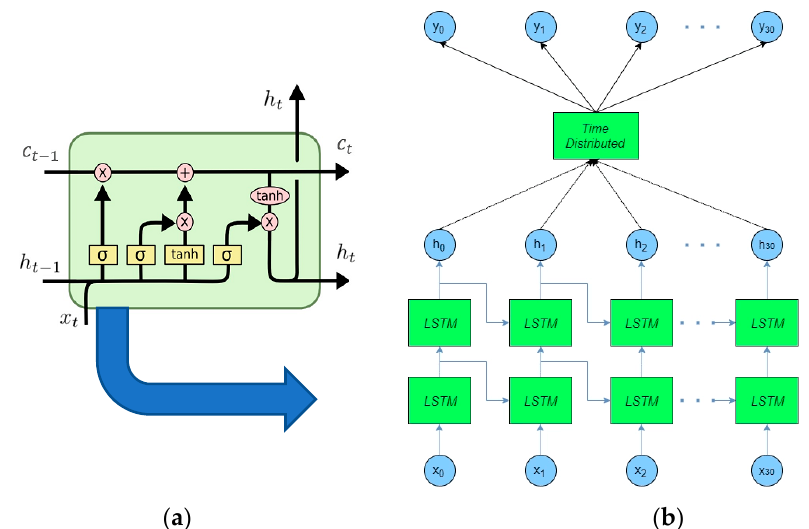
Figure 8. PTP DL-based techniques to references mapping.